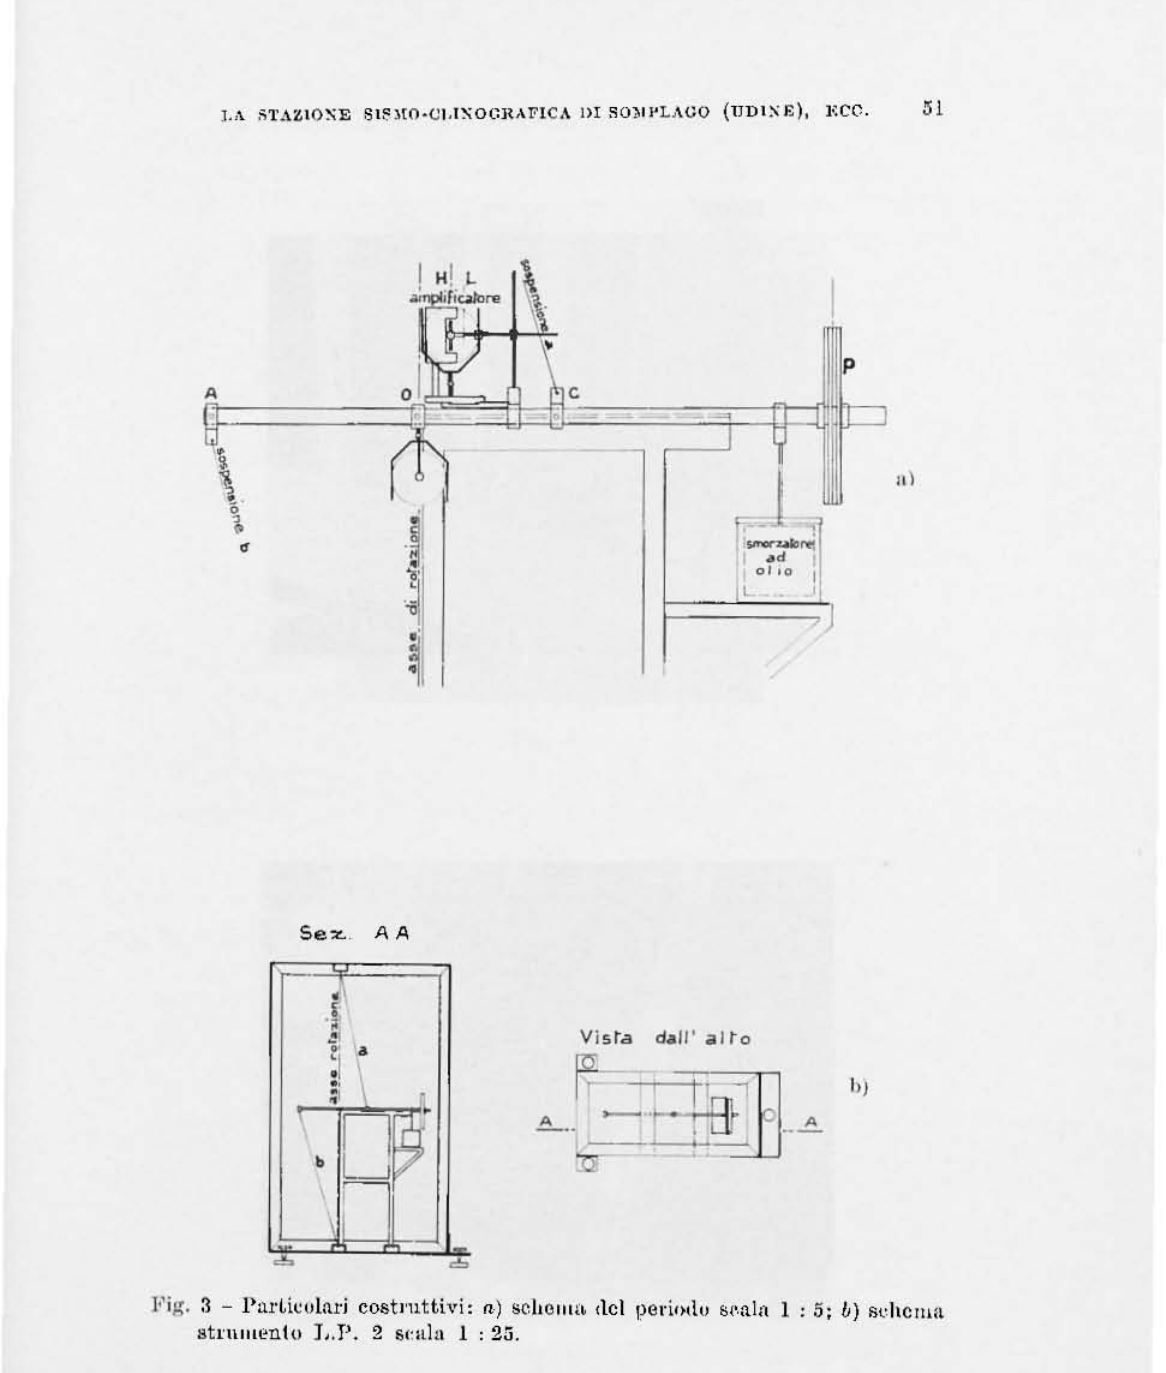
Fig. 3 - l':lr~icol:lrj costl"llttivi: a) SC!.OIll.\ llcl peril1-\lo s{'.:lln l : 5; h) flehcllIa struillen to L.I'. 2 6" u111 l :